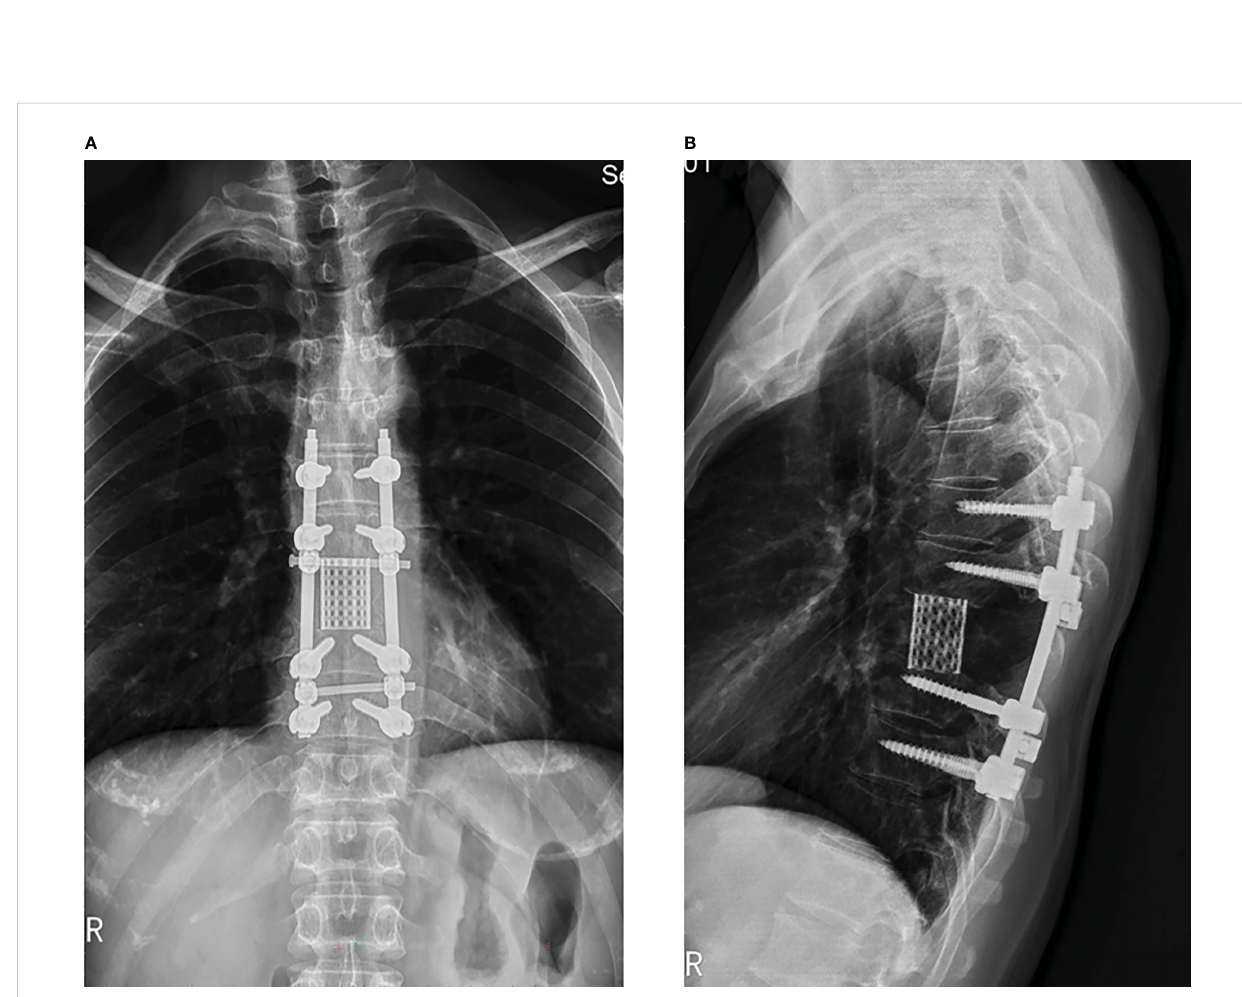
FIGURE 7 3 months follow-up after the surgery, x-ray display of thoracic spine showing transpedicular screw and a titanium mesh were used in the reconstruction of the stability of the spine in patient. ( A : orthotopic position, B : side